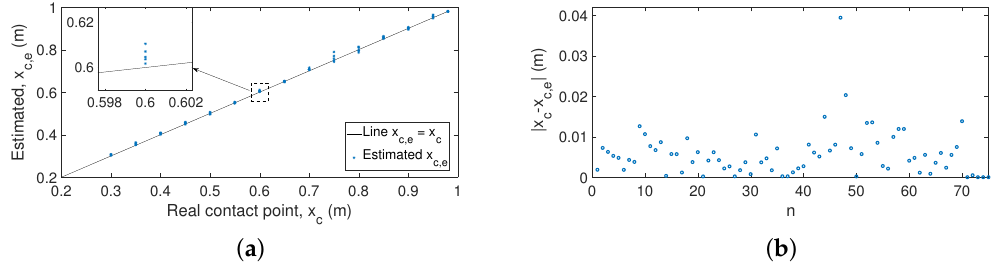
Figure 16. Experimental results obtained for the estimation of the contact point for Case 1: ( a ) estimated x c , e versus real x c ; ( b ) absolute